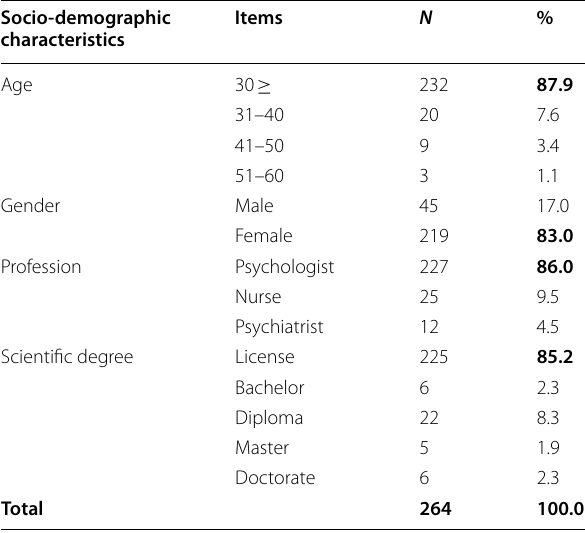
Table 1 Socio-demographic characteristics among mental